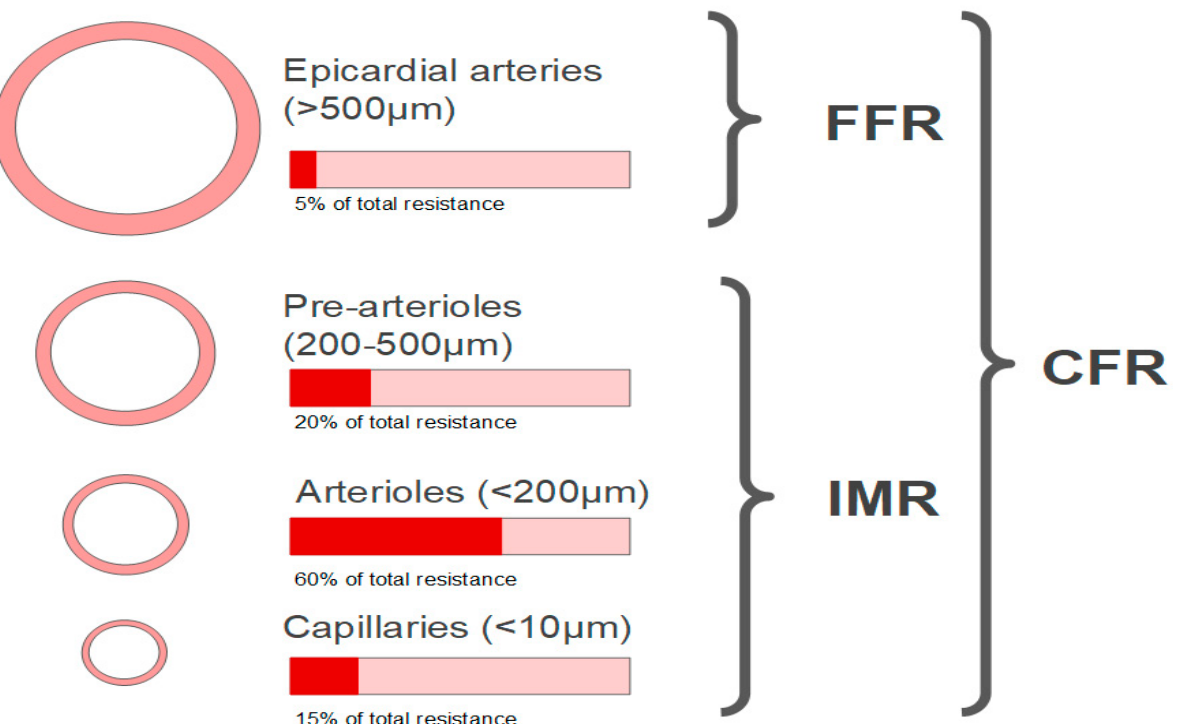
Figure 7. Anatomy of the coronary arterial system and invasive diagnostic modalities to assess coronary microvascular function. FFR: fractional flow reserve; IMR: index of microvascular resistance; CFR: coronary flow reserve.